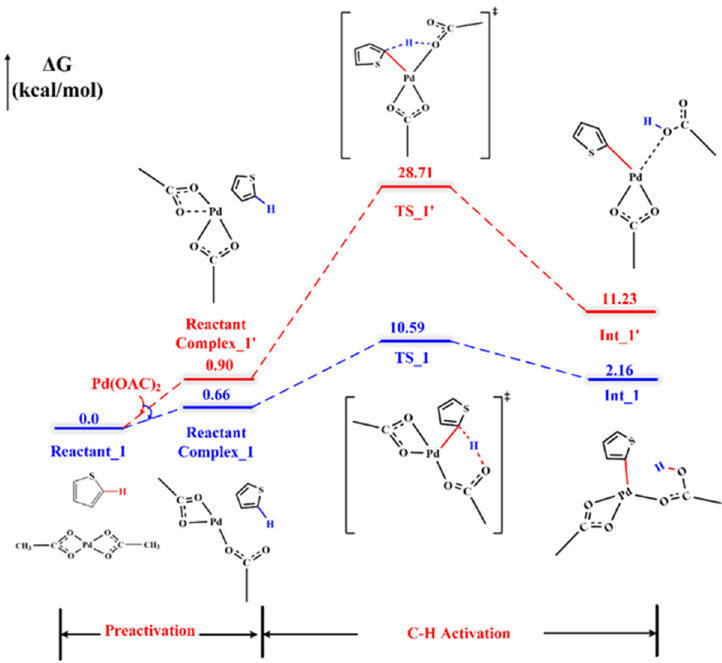
Figure 1. Reaction energy profiles of C–H bond cleavage step for CMD (blue curve) and σ -metathesis (red curve) modes.